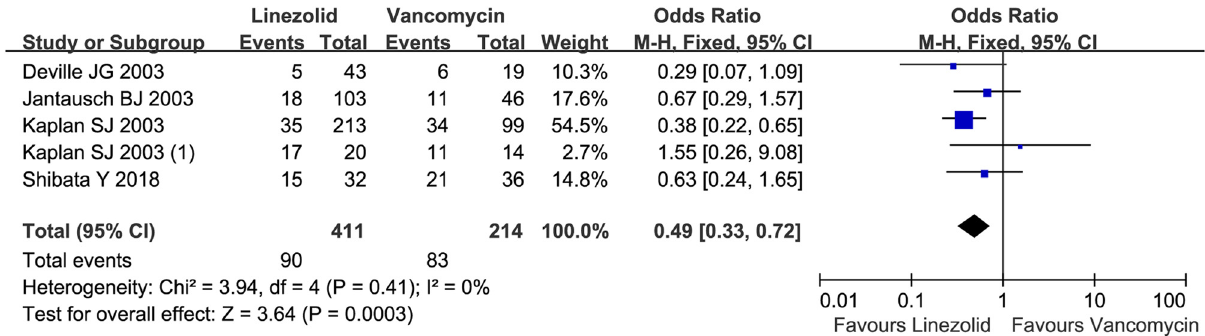
Figure 4: Total adverse event rate by linezolid vs. vancomycin in the treatment of resistant Gram - positive bacterial infections in children < 12 years. M - H, Mantel - Haenszel; CI, con fi dential